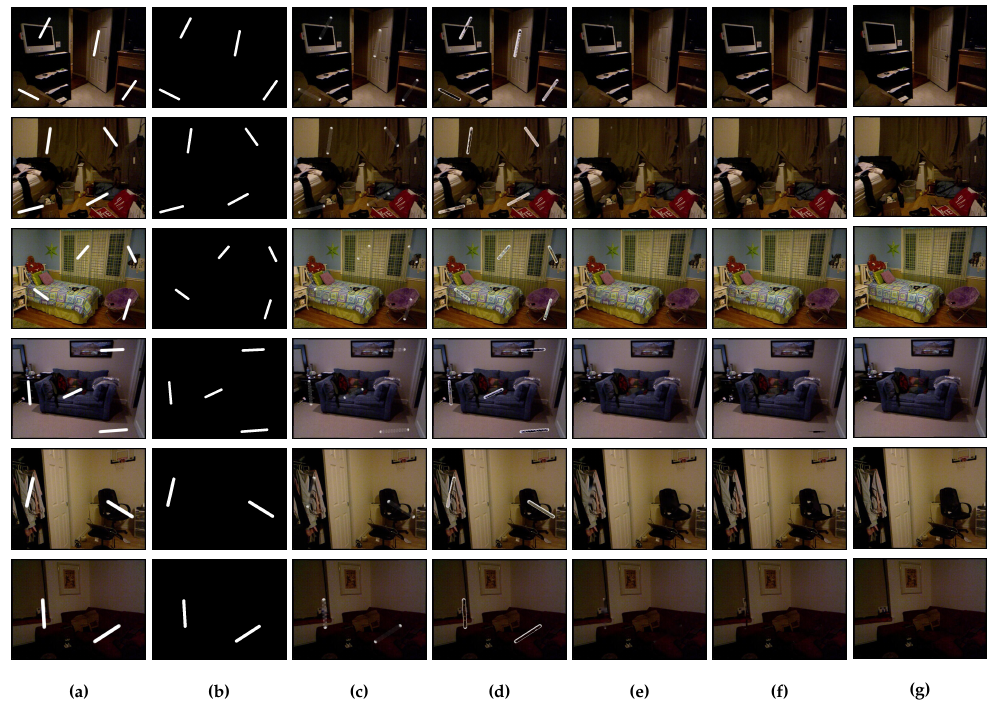
Figure 10. RGB image inpainting results. ( a ) Input. ( b ) Mask. ( c ) FMM results. ( d ) BBIM results. ( e ) Ours (based on FMM). ( f ) Ours (based on BBIM). ( g ) Ground